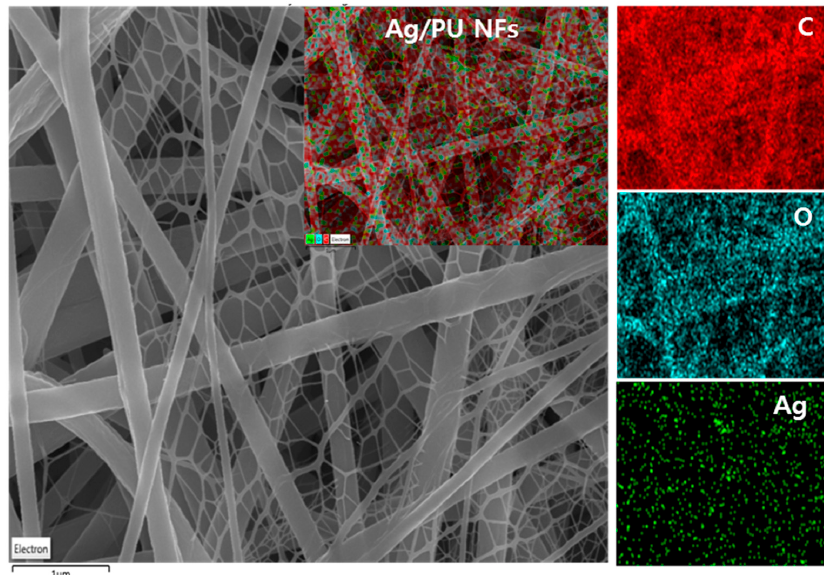
Figure 3. Elemental mapping of the Ag/PU NF sample showing the distribution of Ag NPs along with carbon and oxygen. Table 1. Conductivity, viscosity, and fiber diameters of the different samples.